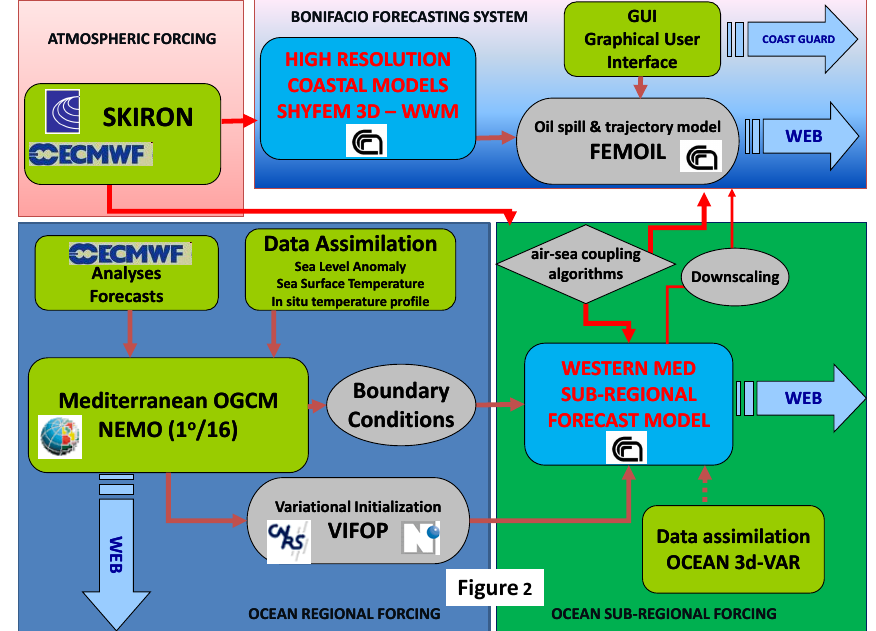
Fig. 2. Scheme of the whole system with different nested numerical forecasting models covering from basin to coastal scale, oceanographic and